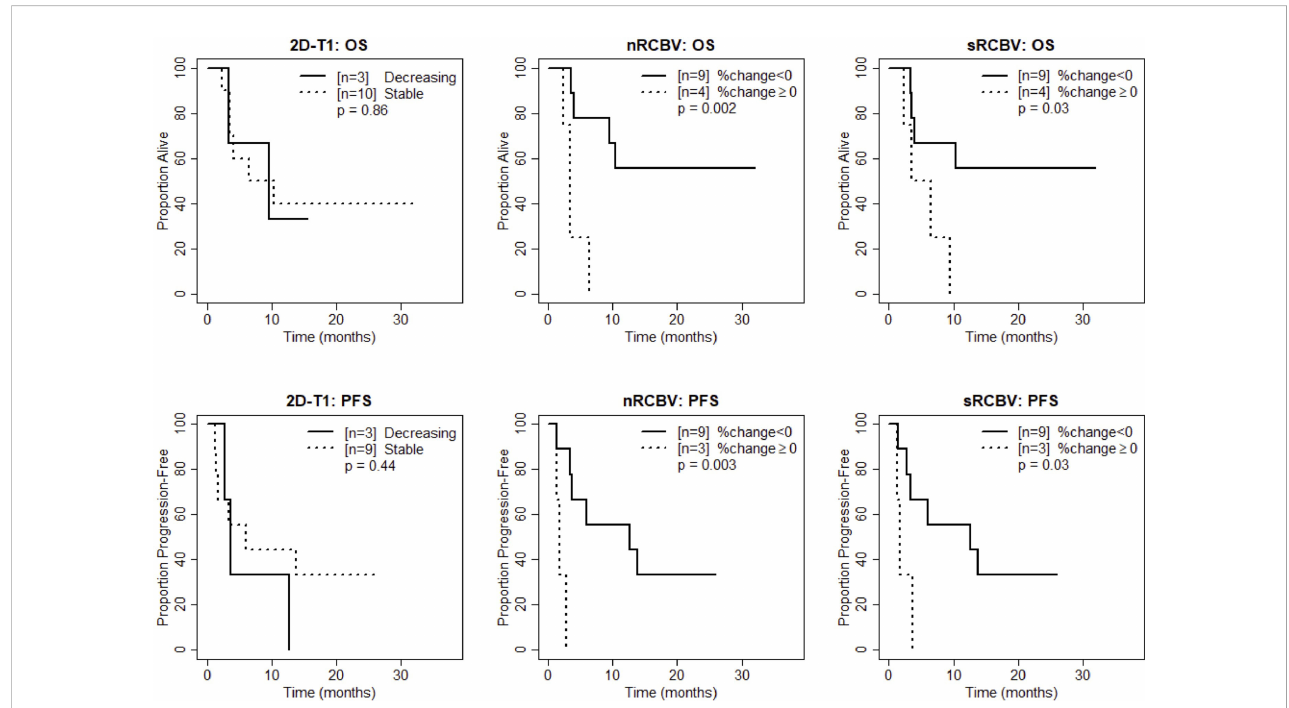
FIGURE 2 Kaplan-Meier curves using week 2 DSC-MRI for time to death (top row) and time to progression or death (bottom row) for T1 non-progressors with stable versus decreasing enhancement on 2D-T1 (left column), T1 non-progressors with decreasing versus increasing normalized rCBV (nRCBV) (middle column), and T1 non-progressors with decreasing versus increasing standardized rCBV (sRCBV) (right column).